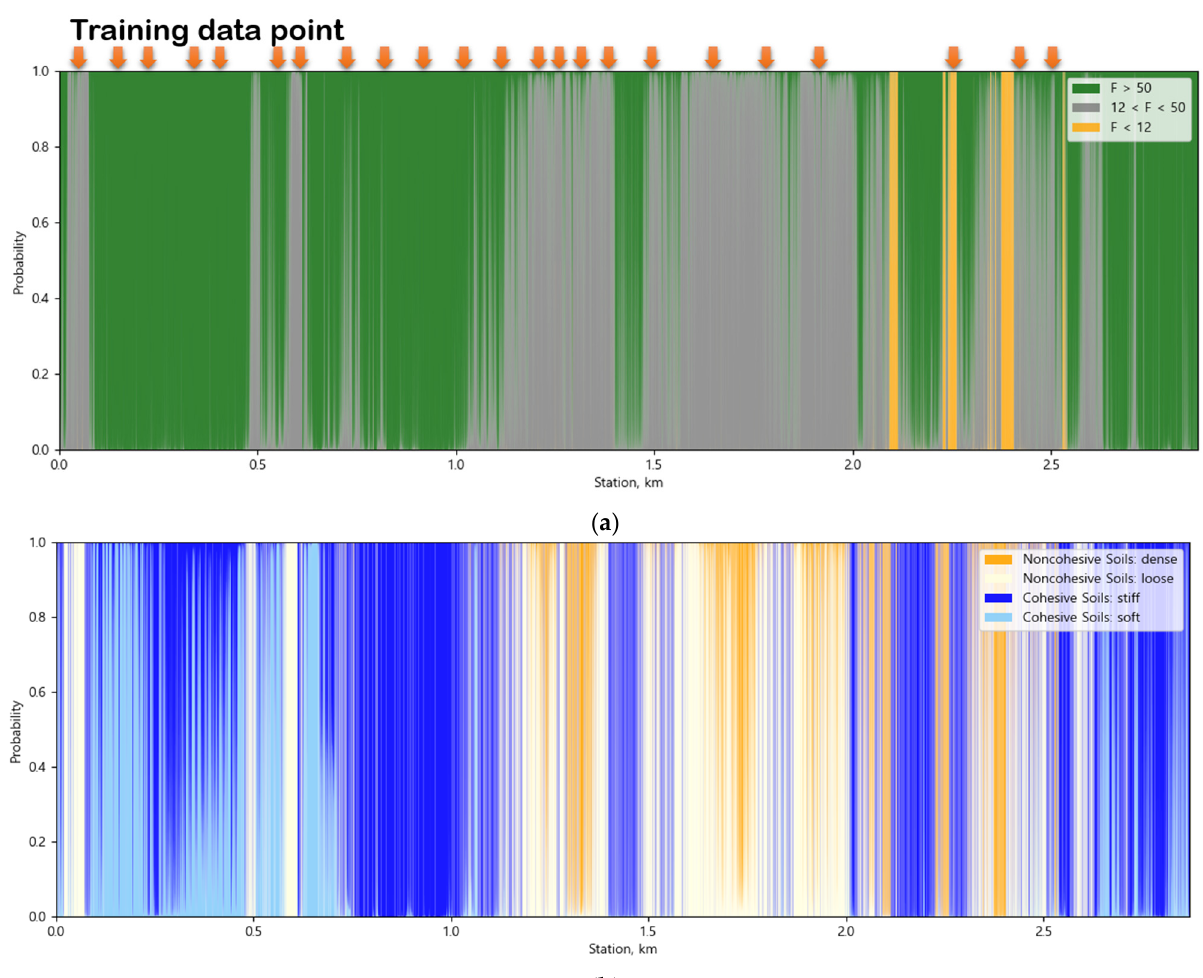
Figure 10. Classification results for the entire dataset: ( a ) classification step 1 (particle size); ( b ) classification step 2 (SPT value).